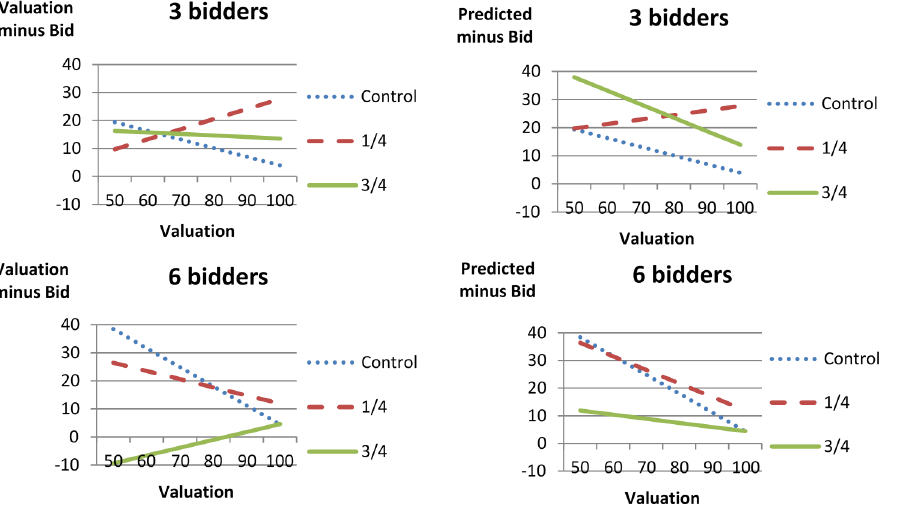
Figure 3. English auctions. Relationship between loser underbidding and